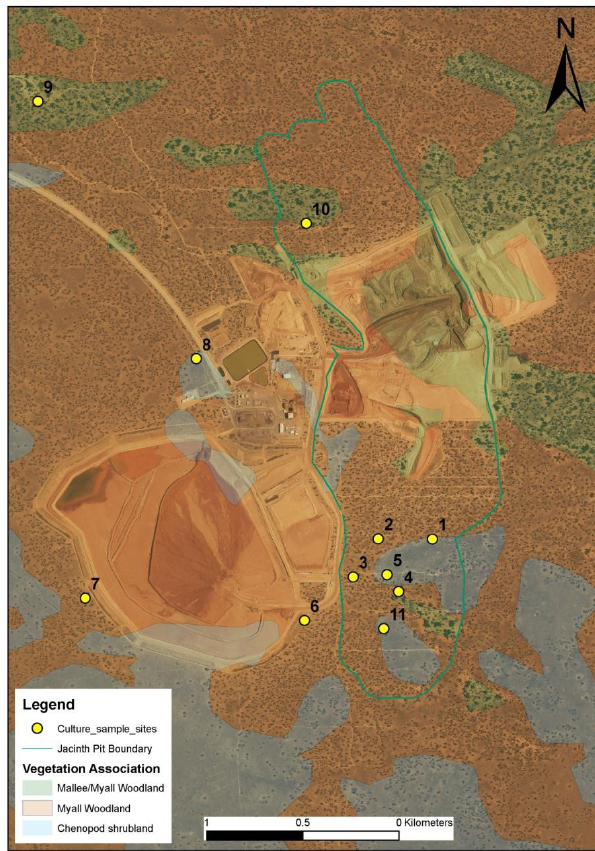
Figure 1. Image of biocrust sample sites located within the vegeta- tion associations described in Table S1 (supplied by Samantha Dou- dle). Site 11 was initially investigated but later discarded as it was a fourth replicate of the chenopod